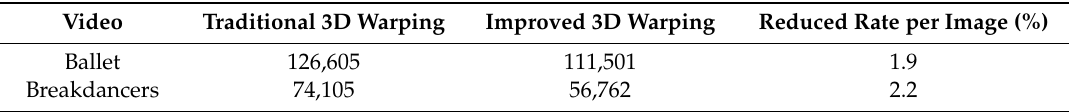
Table 1. Average number of holes (pixel points) for one image compared with traditional 3D warping and improved 3D